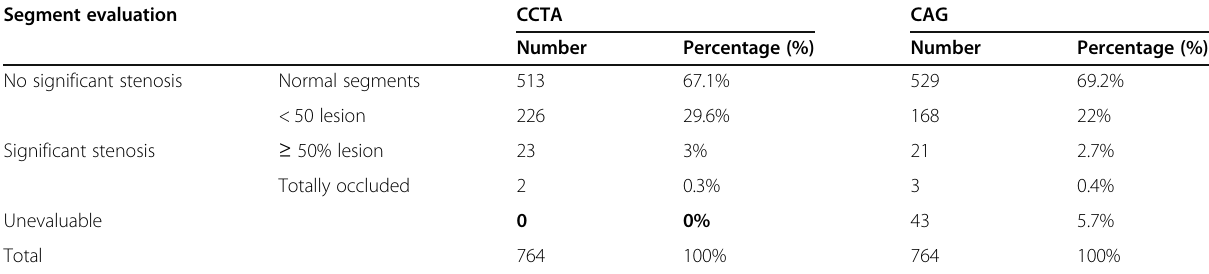
Table 2 Distribution of normal, non-stenotic, significantly stenotic, and non-evaluable segments among both techniques Segment